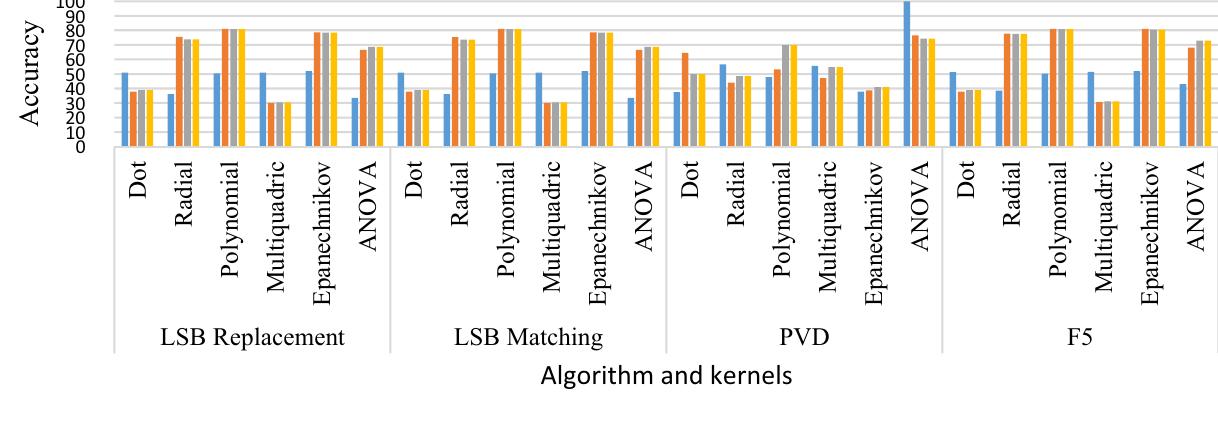
Graph 3. Result of classification of uncalibrated images using SVM-PSO for random